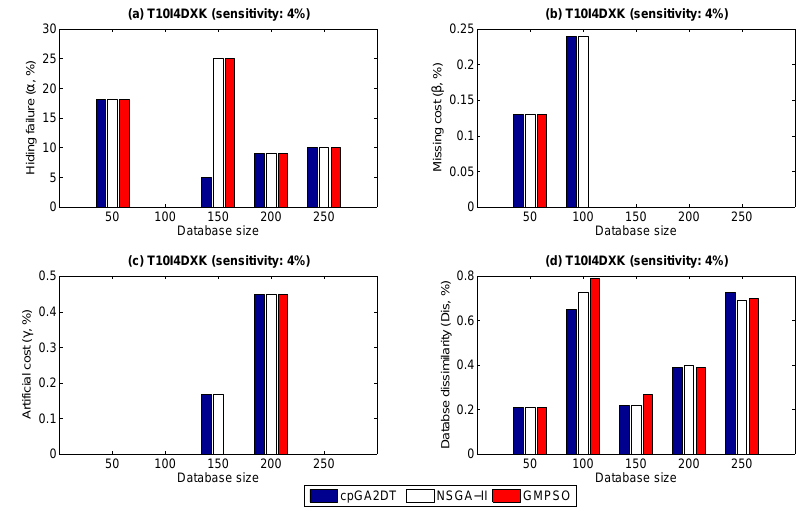
Figure 8. Scalability under varied database